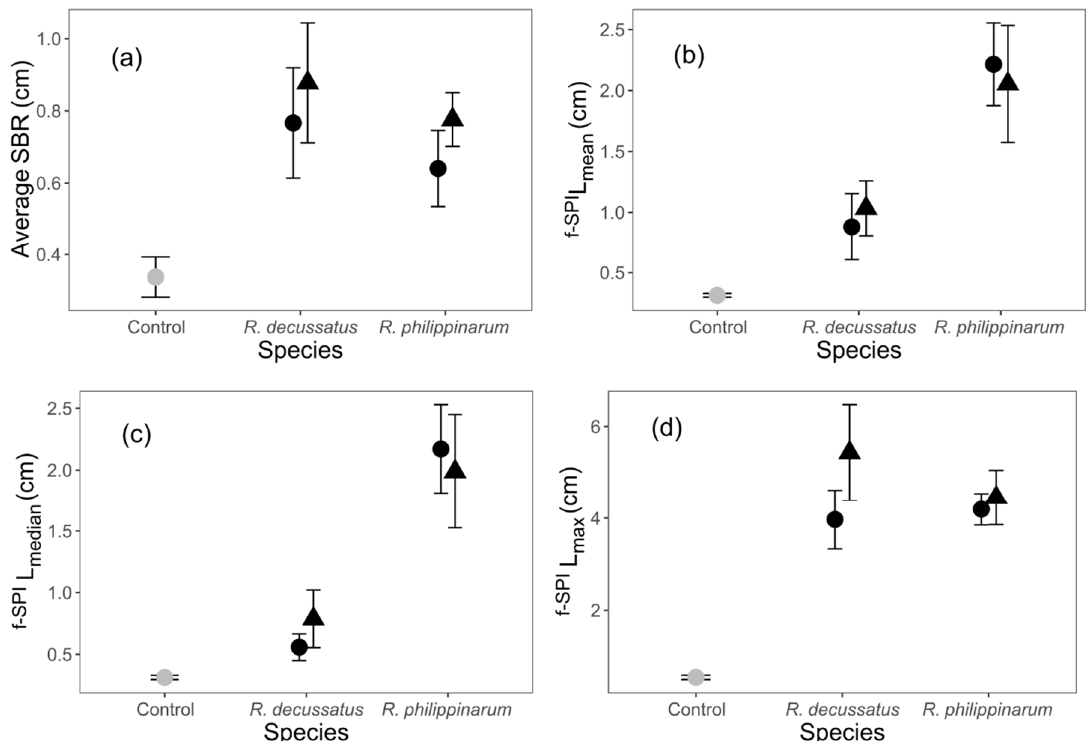
Figure 1. The effects of different temperature treatments on the sediment reworking by Ruditapes decussatus and R. philippinarum (cm, mean ± SE): ( a ) Surface boundary roughness (SBR), ( b ) mean mixed depth of luminophores’ redistribution ( f-SPI L mean ), ( c ) median mixed depth of luminophores’ redistribution ( f-SPI L median ), and ( d ) maximum mixed depth of luminophores’ redistribution ( f-SPI L max ), at day 12. For clarity, jitter has been applied to the × = argument of the plot function to avoid overplotting. For comparison, measurements in the absence of animals are presented (grey, control). constant temperature; heat wave; n = 20.